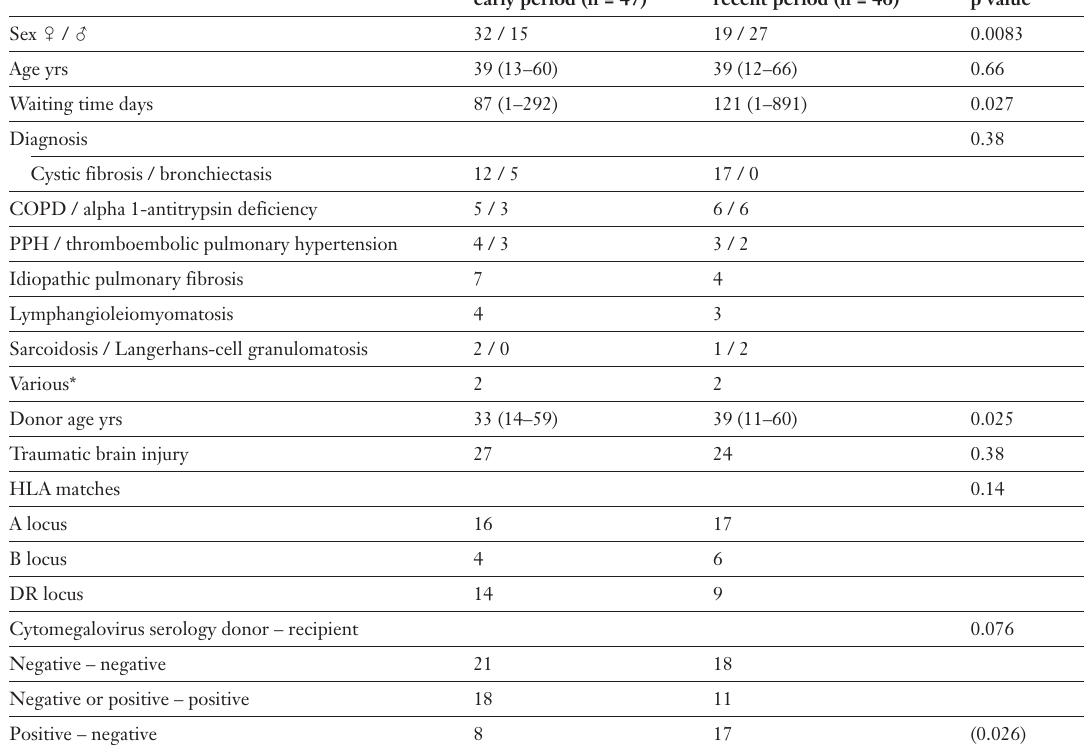
Baseline characteris- tics of the two study populations. Data are expressed as num- bers or medians, with ranges shown in